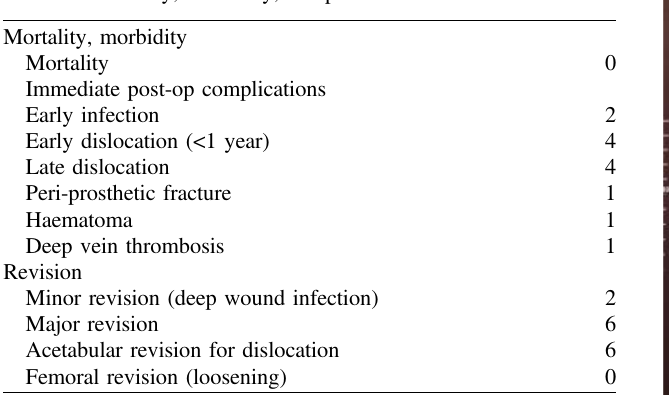
Table 2. Mortality, morbidity, complications.